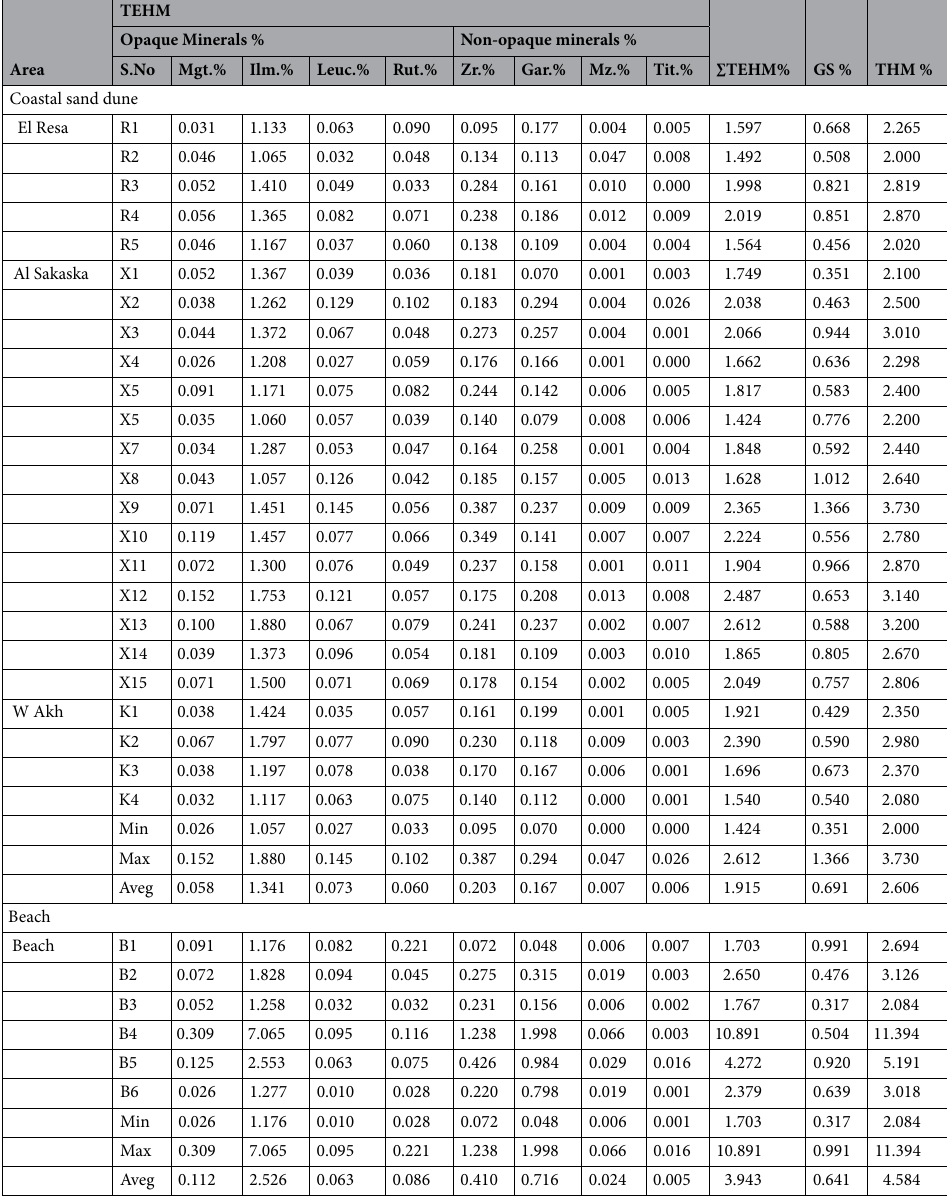
Table 2. The percentages of heavy minerals for studied sediments. S. No. = Sample number, Mgt. = Magnetite, Ilm. = Ilmenite, Leuc. = Leucoxene Rut. = Rutile Zr. = Zircon, Gar. = Garnet, Mz. = Monazite, Tit. = Titanite, GS = Green silicates, TEHM = Total Economic Heavy Minerals, THM = total heavy minerals; W Akh = Al Wadi Al